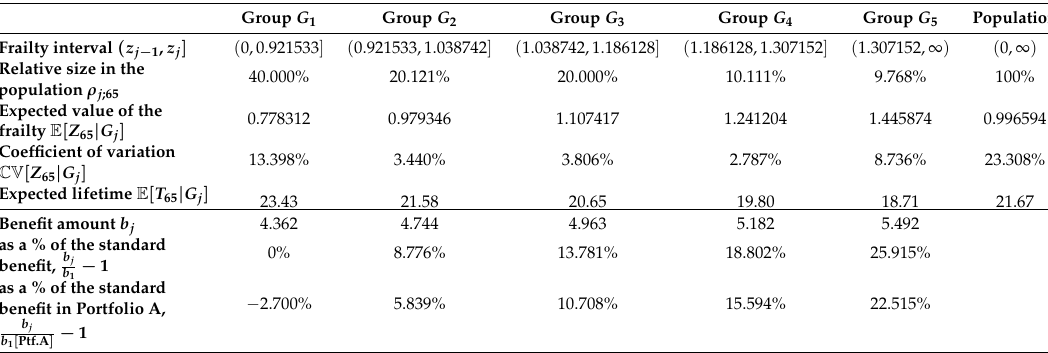
Table 15. Portfolio H: tariff structure and benefit